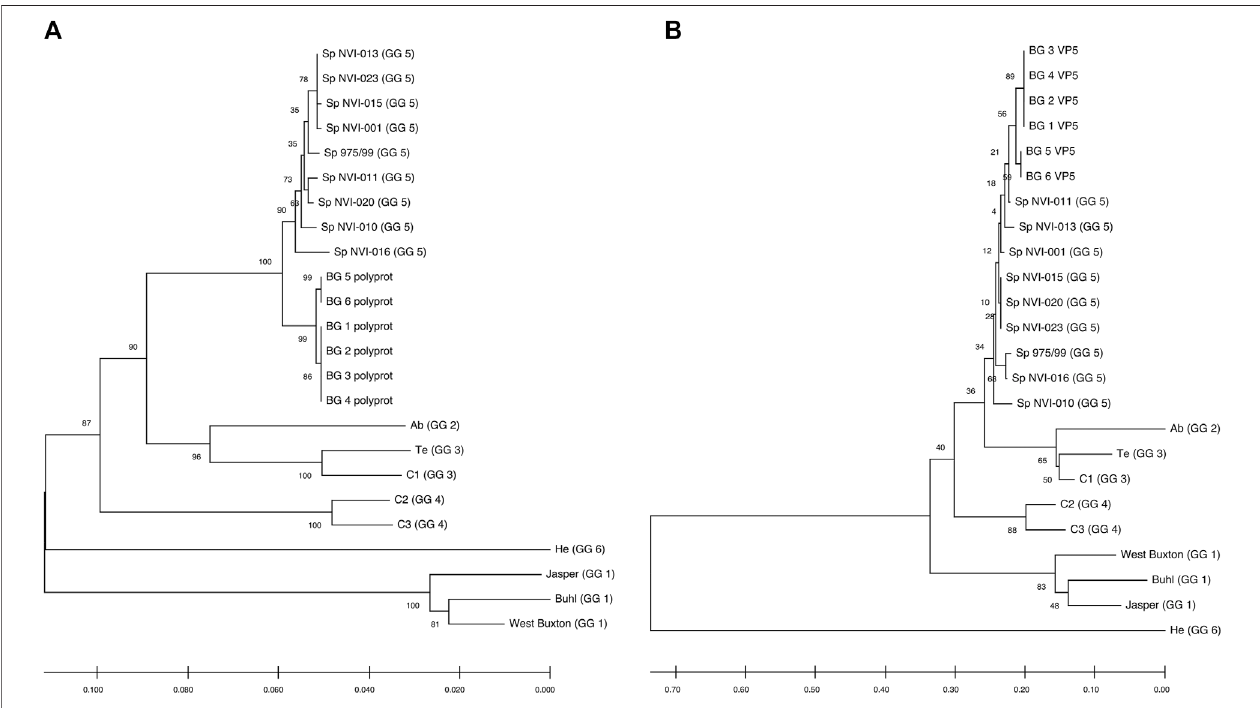
FIGURE2| Neighbour-Joiningtree,showingthephylogeneticrelationshipbetweenthe (A) Polyproteinand (B) VP5 ’ sdeducedaminoaciddatafromdifferentIPNV reference strains and the assemblies reported in this study. The accession ids of the sequences are presented in Table 2 . The associated genogroups are in parentheses. Except for the Sp 975/99, which was recovered from the Shetland Isles, Scotland (Smail et al., 2006), all the Sp serotypes are based on different fi eld outbreaks found in the Northwest of Norway (Santi et al., 2004). BG 1 to 6 represent isolates identi fi ed in the current work. The con fi dence of association between sequences was estimated using bootstrap testing (1,000 replicates) and is shown next to the branches. The evolutionary distances were computed using the Poisson correction method (Zuckerkandl and Pauling, 1965) and are in the units of the number of amino acid substitutions per site. The rate variation among sites was modeled with a gamma distribution (shape parameter (cid:1) 1). All ambiguous positions were removed in a pairwise deletion fashion.